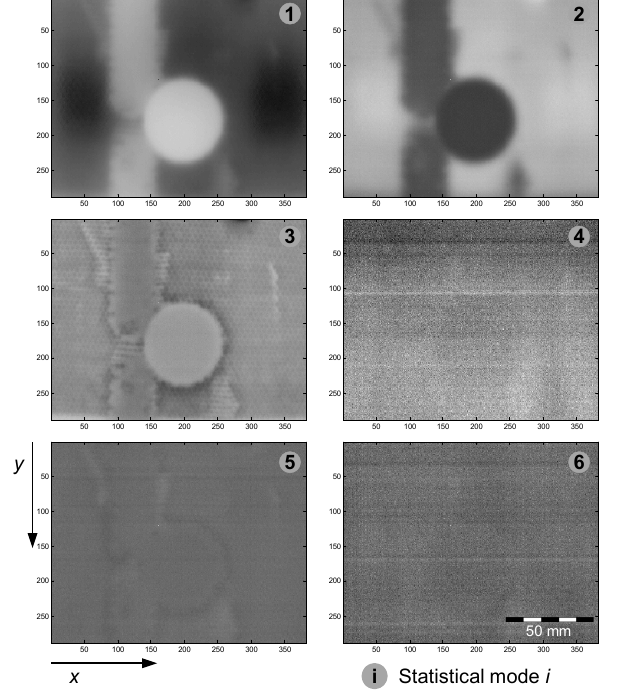
Figure 4. Thermal images at the time steps n t for the GFRP spec- imen (a) and the CFRP specimen (b) (first image in heating, first and last image in cooling phase).